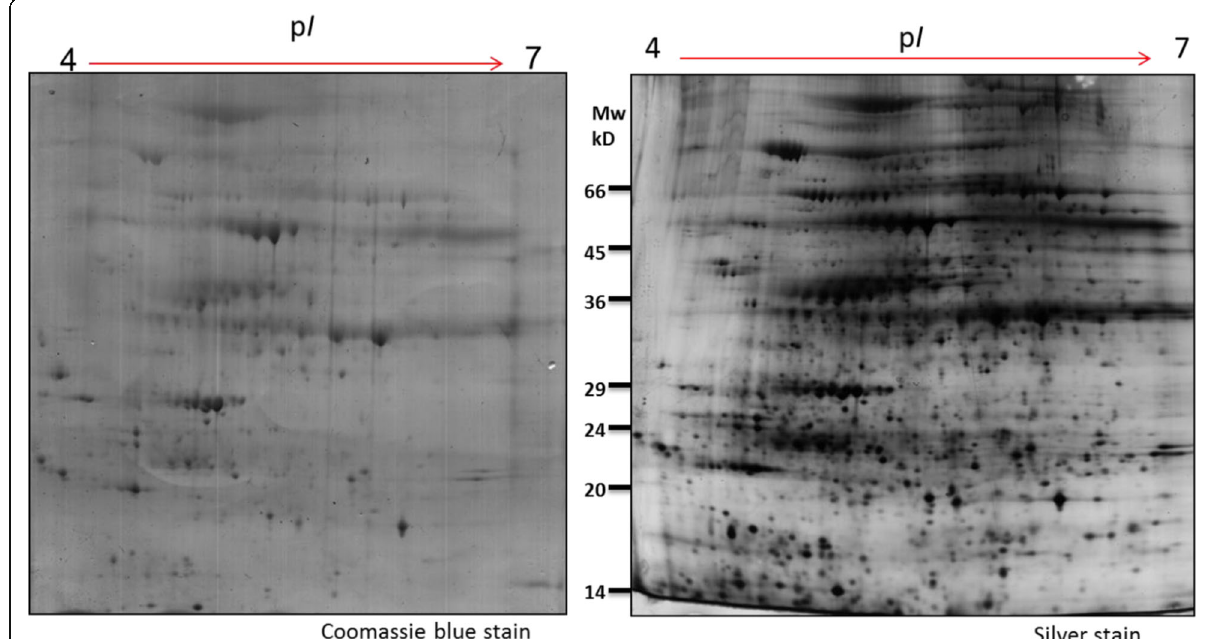
Fig. 1 2-DE gel images of leaves protein extracted from K1 line treated for 4 h at 45 °C. An equal amount from total proteins (1 mg) was loaded in each gel, protein spots were detected with CBB-R250 and silver